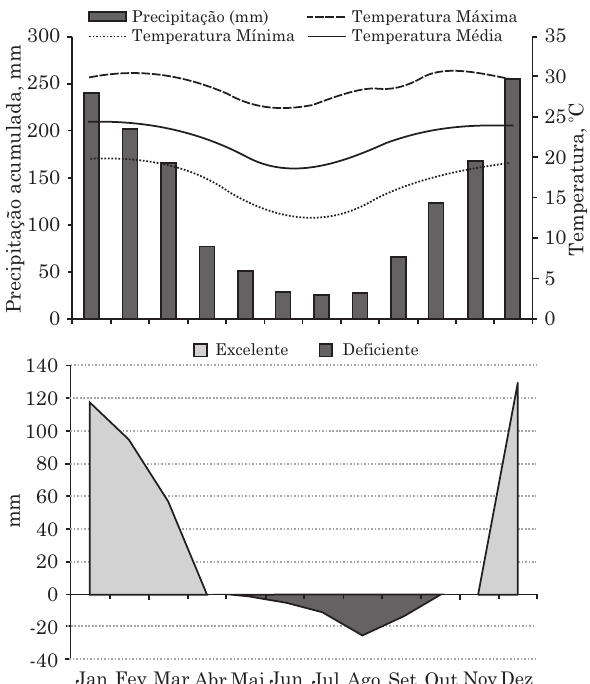
Figura 1. Valores médios mensais de temperatura do ar e de precipitação pluvial acumulada e extrato do balanço hídrico climatológico normal para Jaboticabal (SP), no período